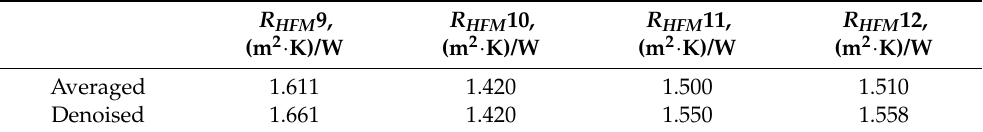
Table 5. Results of conductive thermal resistance calculations. R HFM 9,